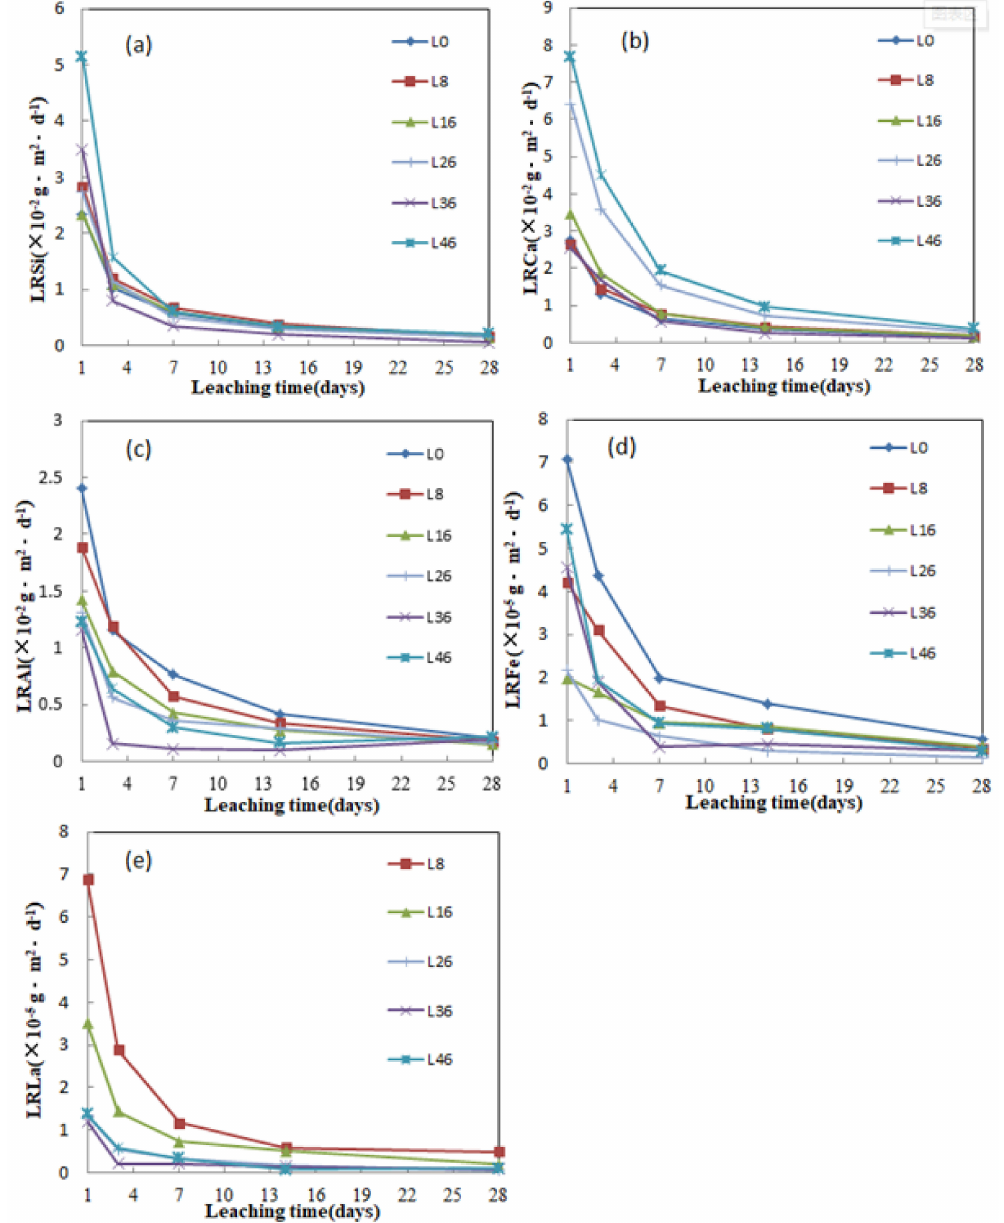
Figure 5. Normalized elemental leach rates of ( a ) Si, ( b ) Ca, ( c ) Al, ( d ) Fe, and ( e ) La of the